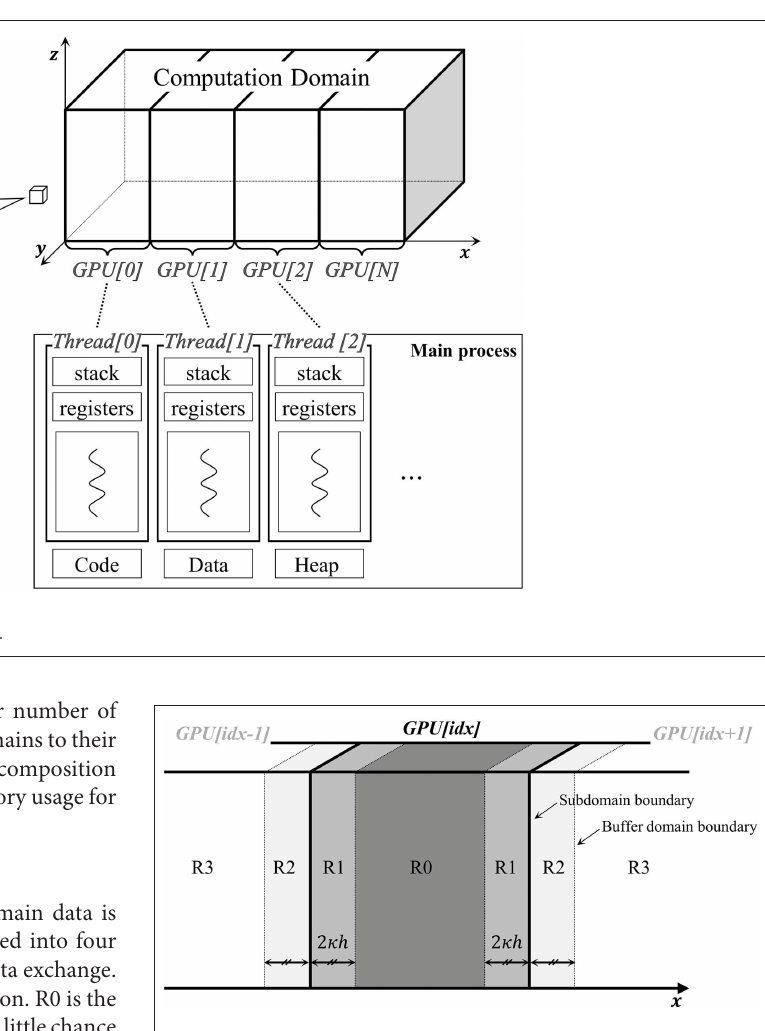
FIGURE 4 | Concept of sub-domain